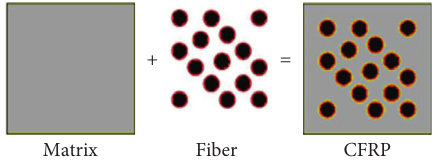
Figure 1: Constituents of composite